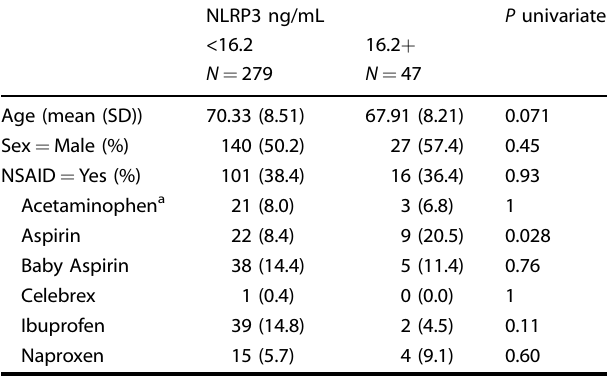
Table 2. Characteristics associated with elevated NLRP3.